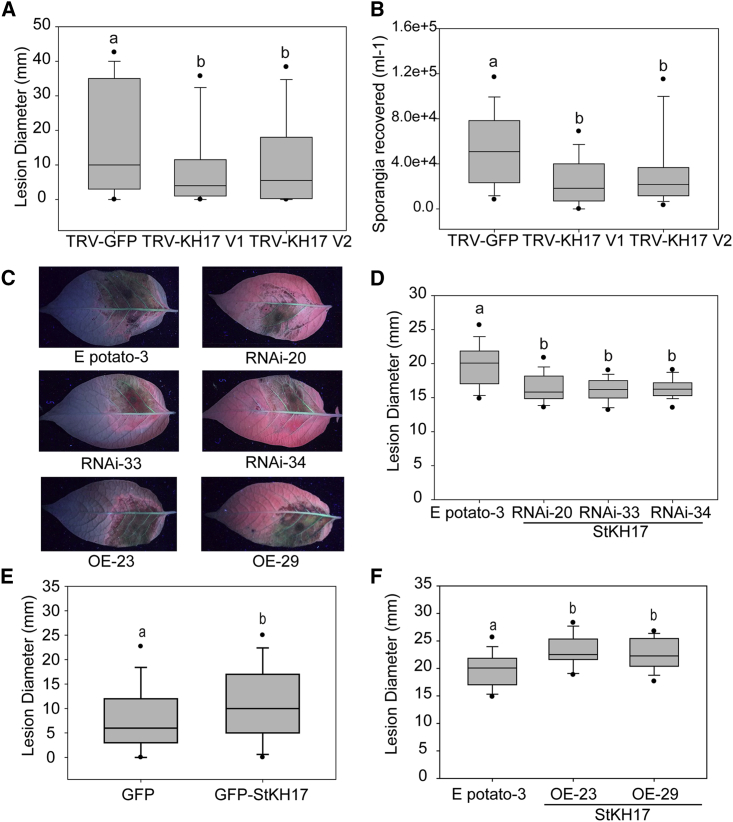
KH17 Silencing by VIGS or Stable RNAi Reduces P. infestans Infection while StKH17 Transient or Stable Overexpression Enhances P. infestans Colonization.(A) Box plot showing lesion diameter is reduced in TRV-KH17-silenced N. benthamiana plants compared to the TRV-GFP control (one-way ANOVA p < 0.001, N = 145), The combined data are shown for six biological replicates comprising ~three leaves from ~four plants per replicate.(B) Box plot showing the sporangia recovered per milliliter is reduced in TRV-KH17-silenced N. benthamiana plants compared to the TRV-GFP control (ANOVA p < 0.001, N = 216). The combined data are shown for six biological replicates comprising ~three leaves from ~four plants per replicate.(C) Representative leaf images taken under UV light showing P. infestans lesions on E potato-3 control and transgenic potato RNAi and overexpression (OE) lines.(D) Box plot showing lesion diameter is reduced in transgenic potato plants silencing StKH17 compared to the E potato-3 control (ANOVA p < 0.001, N = 30). The combined data are shown for three biological replicates comprising ~two leaves from ~five plants per replicate.(E) Box plot showing the lesion diameter is increased in the halves of N. benthamiana leaves transiently overexpressing GFP-StKH17 compared to those overexpressing free GFP (ANOVA p = 0.006, N = 105). The combined data are shown for three biological replicates comprising ~three leaves from ~six plants per replicate.(F) Box plot showing the lesion diameter is increased in transgenic potato plants overexpressing StKH17 compared to the E potato-3 control (ANOVA p < 0.001, N = 30). The combined data are shown for three biological replicates comprising ~two leaves from ~five plants per replicate.Error bars are SD and the median is marked with a horizontal line. Black dots show the 5th and 95th percentile data points. Lowercase letters indicate significant differences tested by one-way ANOVA with pairwise comparisons performed using the Holm-Sidak test.